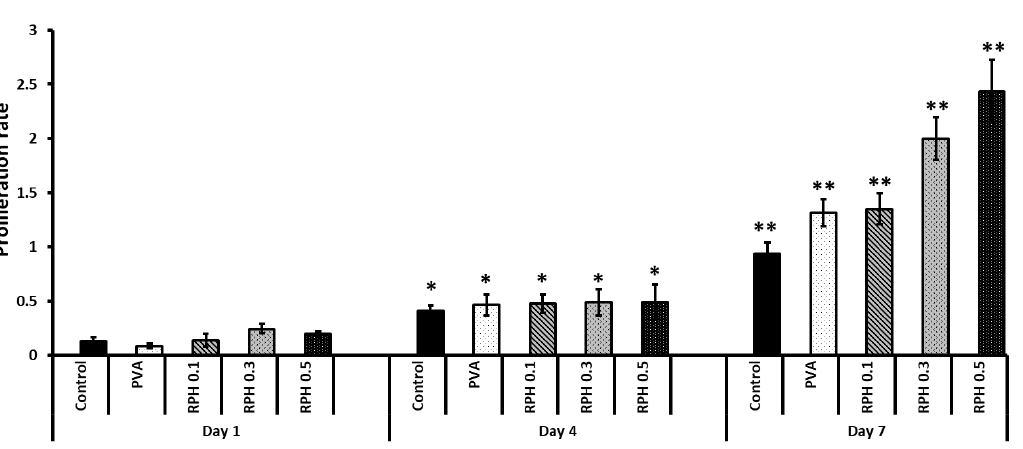
Figure 7. The effect of RPHX hydrogels on the proliferation of bone marrow mesenchymal stem cells cultured for 1, 4, and 7 days. Control cells treated without hydrogel, PVA solution 15 wt.%, RPH 0.1-0.1% retinol PVA, RPH 0.3-0.3% retinol PVA, RPH 0.5-0.5% retinol PVA. Asterisks represent statistical significance, * p < 0.05 vs. Day 1, ** p < 0.001 vs. Day 1 of respective group.